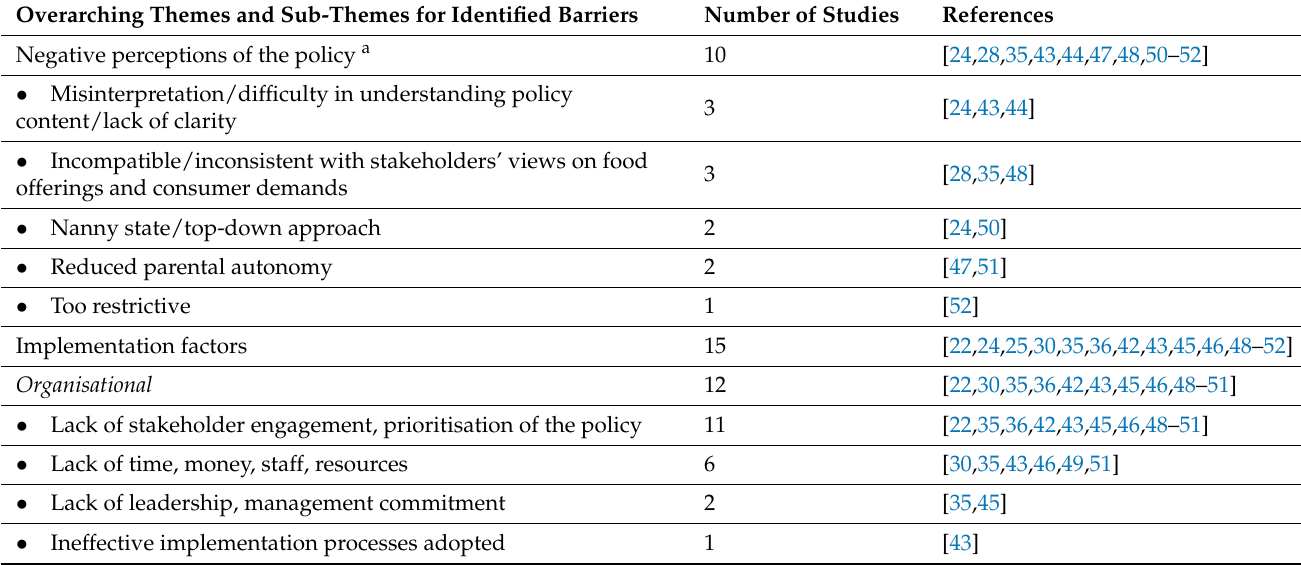
Table 2. Barriers identified in included studies according to overarching themes and sub-themes. Overarching Themes and Sub-Themes for Identified Barriers Number of